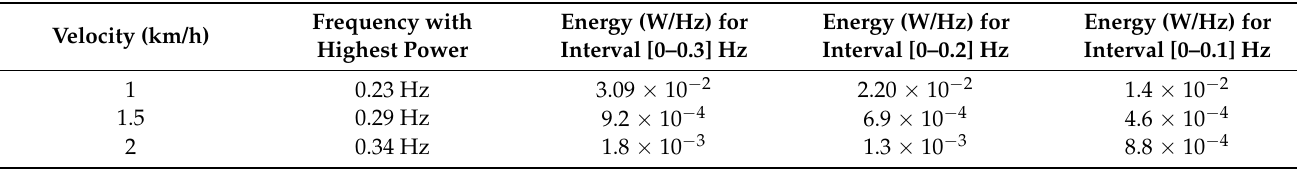
Table A1. Results from spectral frequency analysis for the kinematic foot signals at the speeds of 1 km/h, 1.5 km/h and 2